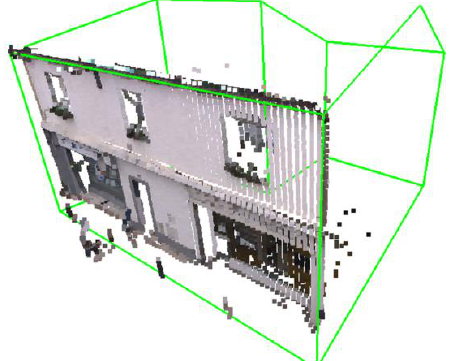
Figure 2: Laser points registered on the 3D model